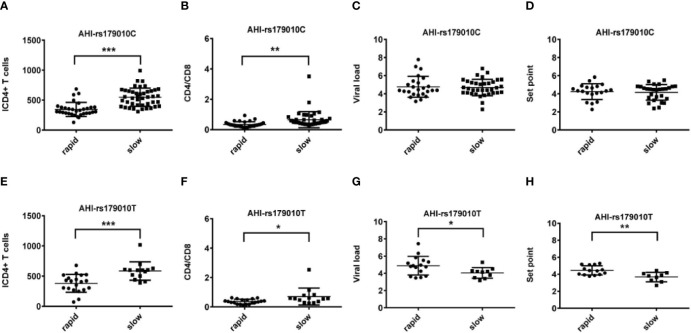
Relationship between clinical parameters and AHI patients with rapid/slow progression who carry rs179010C/T. (A–H) There are four clinical parameters including, ICD4 (initial CD4 T cells) (A, E), CD4/CD8 (the ratio of CD4 versus CD8 T cells) (B, F), viral load (C, G), and set point (D, H). The y axis indicates the values of these four respective parameters. The x axis indicates two AHI patient groups with rapid or slow progression. The text on the top of each picture indicates allele rs179010C/T. Each dot represents an MSM individual, (●) represents individuals of AHI-rapid progress with TLR7 rs179010C/T allele. (■) represents individuals of AHI-slow progress with TLR7 rs179010C/T allele. * indicates P<0.05; **P < 0.01 and ***P < 0.001.